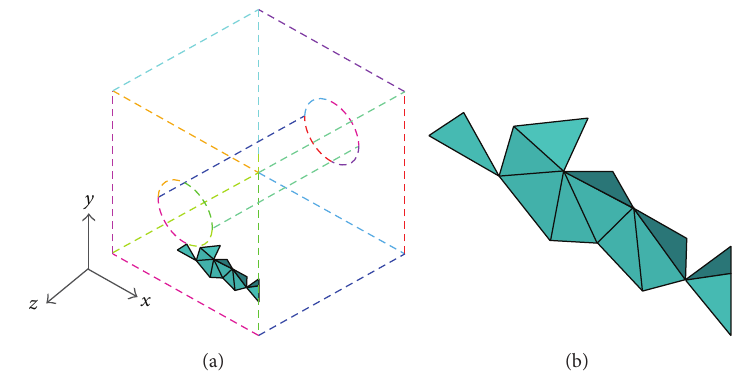
Figure 12: Element selected by crossing the defined path.